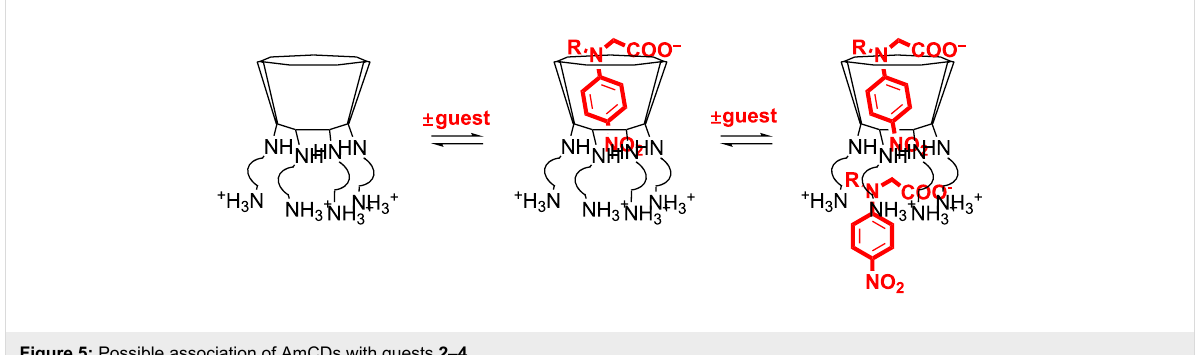
Figure 5: Possible association of AmCDs with guests 2 – 4 .